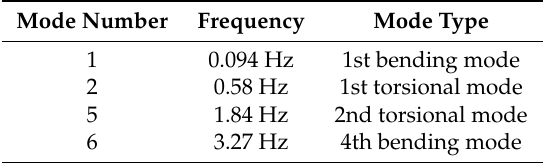
Table 1. Description of the various vibration modes of the cantilevered